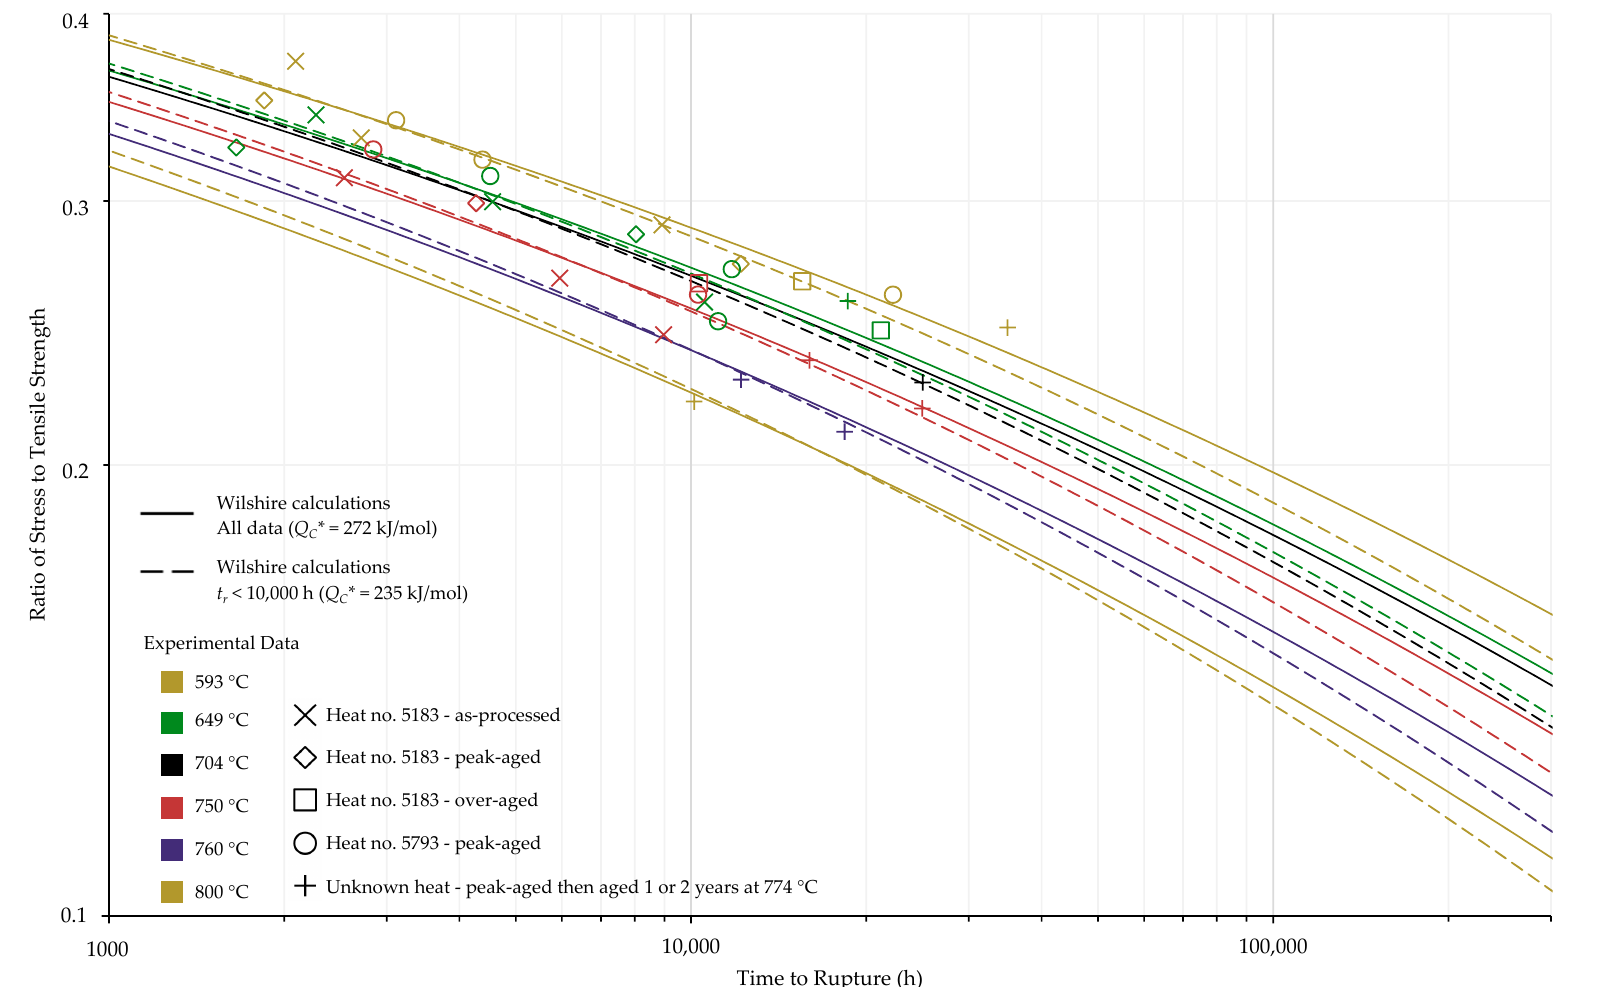
Figure A18. Calculations of the Wilshire equation for Nimonic 105 using heat ‐ and processing ‐ specific tensile strength values with (cid:1843) (cid:3004)∗ determined by optimizing the correlation of data on a Wilshire plot.